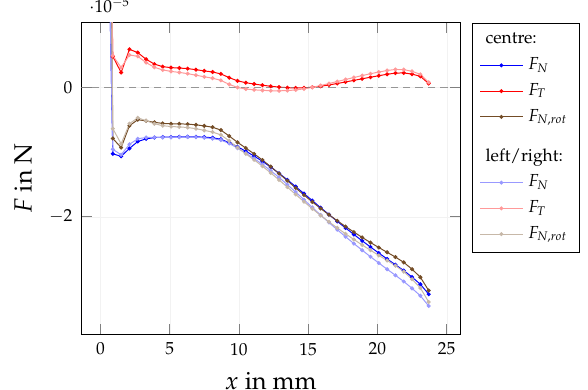
Figure 21. Distribution of tangential forces F t , standard normal forces F n and rotation-induced normal forces F n , rot in central and outer PM fragment